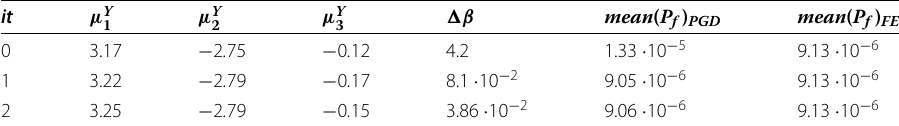
Table 6 Cross-section: summary of itPGDrel process is given by the averaged design in the normal space as well as the failure probability ranges with N = 1600 based point μ h it on PGD and FE model (50 runs, p 0 = 0 . 1 , N p = 100 and ξ = 10 ) it μ Y